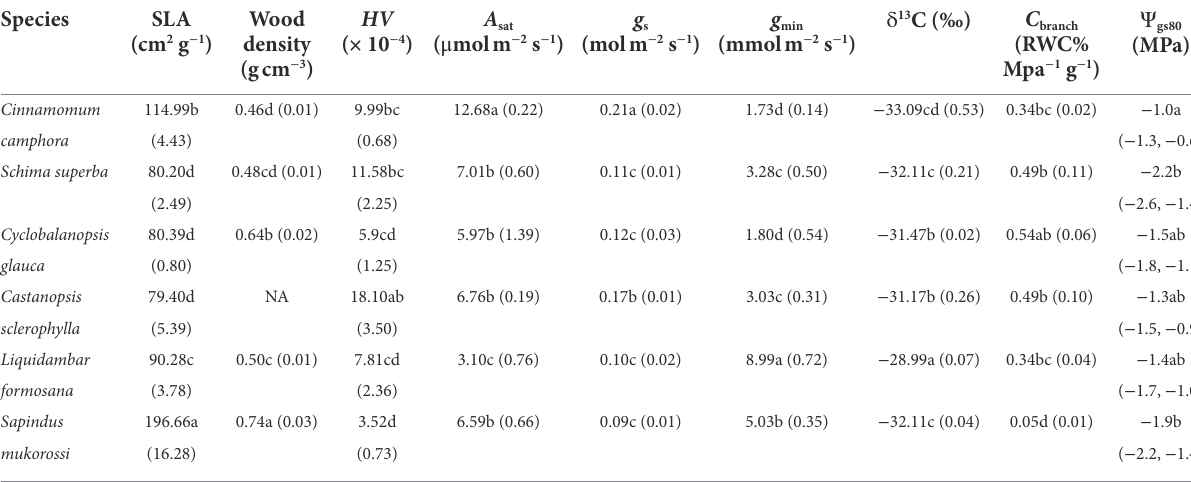
TABLE 2 Plant economic and hydraulic traits for pre-drought seedlings of the six tree species.